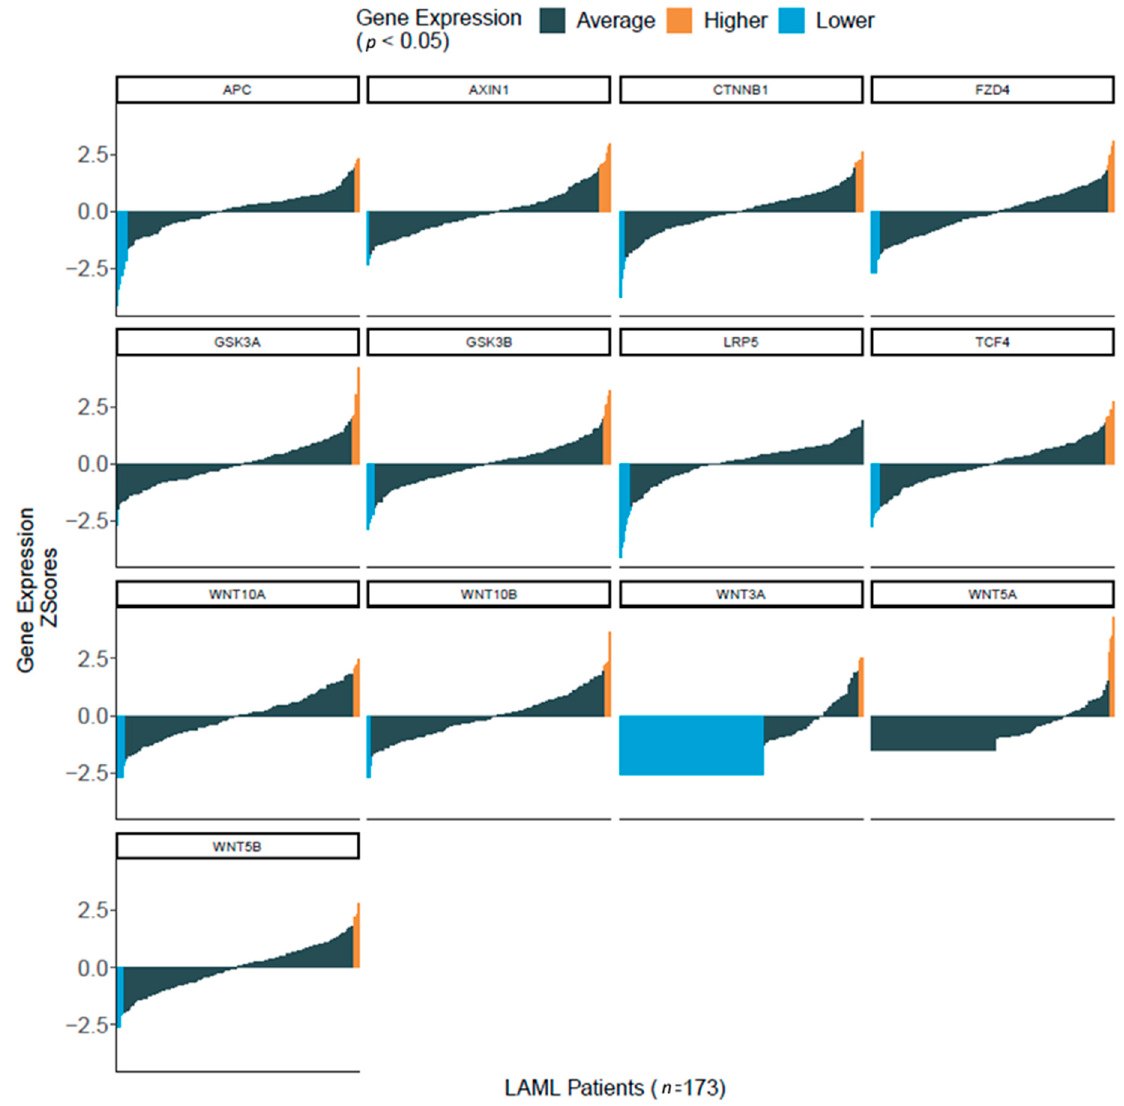
Figure 2. Enrichment of Wnt signaling component in primary AML samples. Wnt signaling expression data from 173 de novo AML samples obtained from The Cancer Genome Atlas RNA-Seq database for AML, Gene expression data in Z-score format were downloaded from the cbioportal R package cgdsr for the TCGA-LAML. Normalized data were used for Z-score calculation. For each mRNA, a sample showing a Z-score higher or lower than the average Z-score for the whole population was considered as having higher or lower expression respectively for the corresponding gene, Z +/ − 1.96 ( p < 0.05).